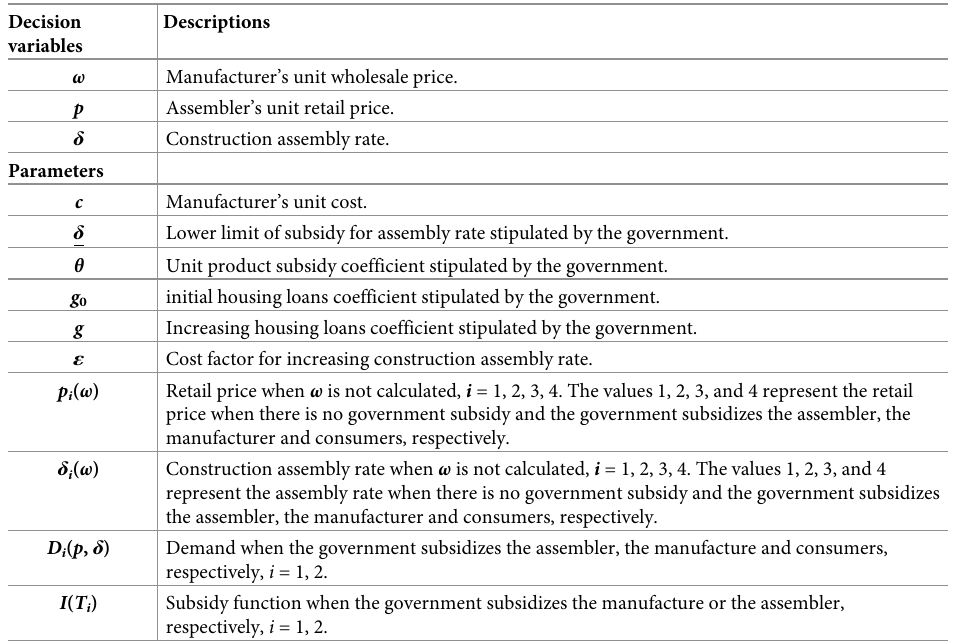
Table 1. Notations of parameters and